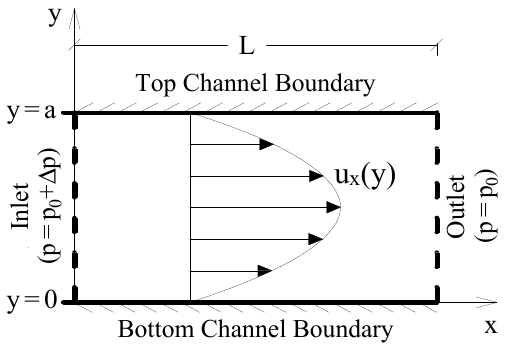
Figure 3. Schematic diagram of a pressure-driven Poiseuille channel flow with velocity profile u x . a and L are width and length of the channel. p 0 is the outlet pressure, and ∆ p is the pressure difference (between inlet and outlet) inducing the fluid flow.